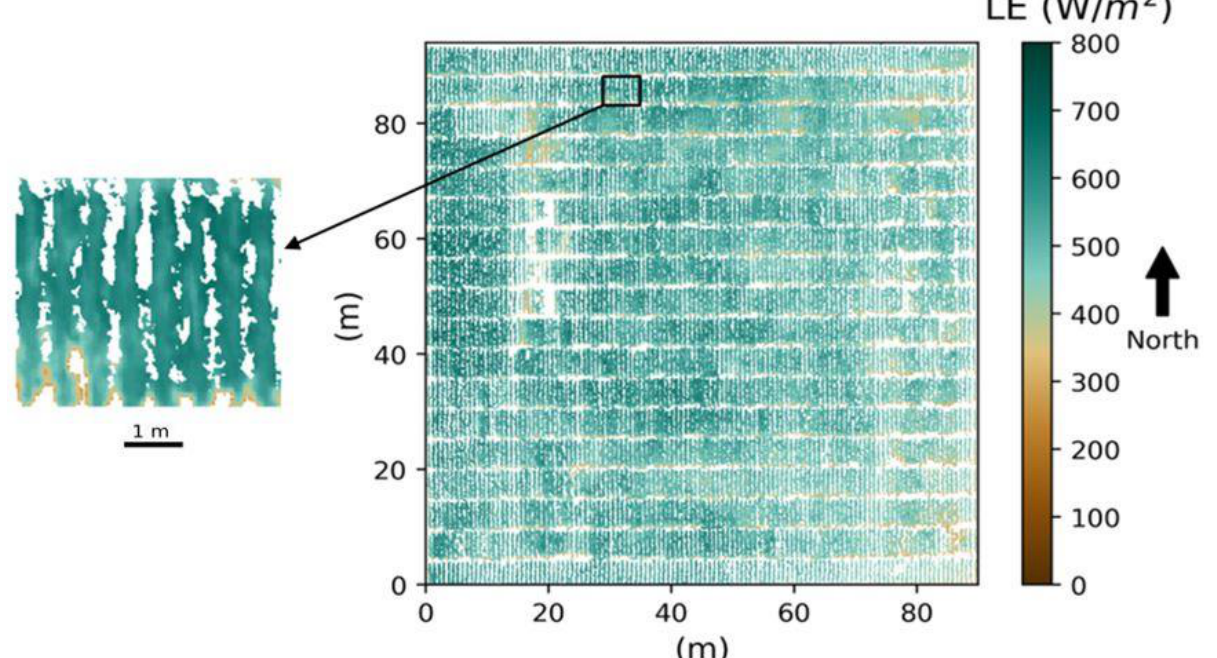
Figure 9. Latent heat flux map of field 54 north on 28 July 2020 with a zoomed in picture showing the plot in detail.